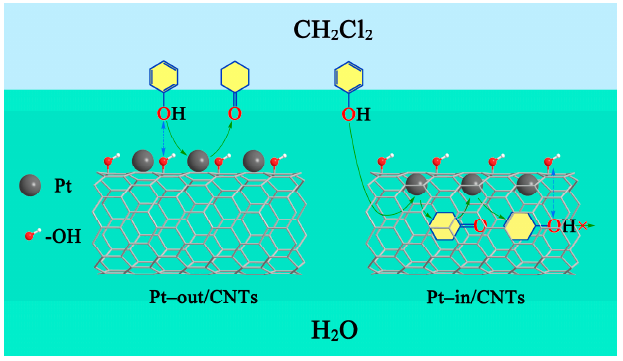
Figure 6. Mechanism of phenol hydrogenation over Pt–in/CNTs and Pt–out/CNTs.